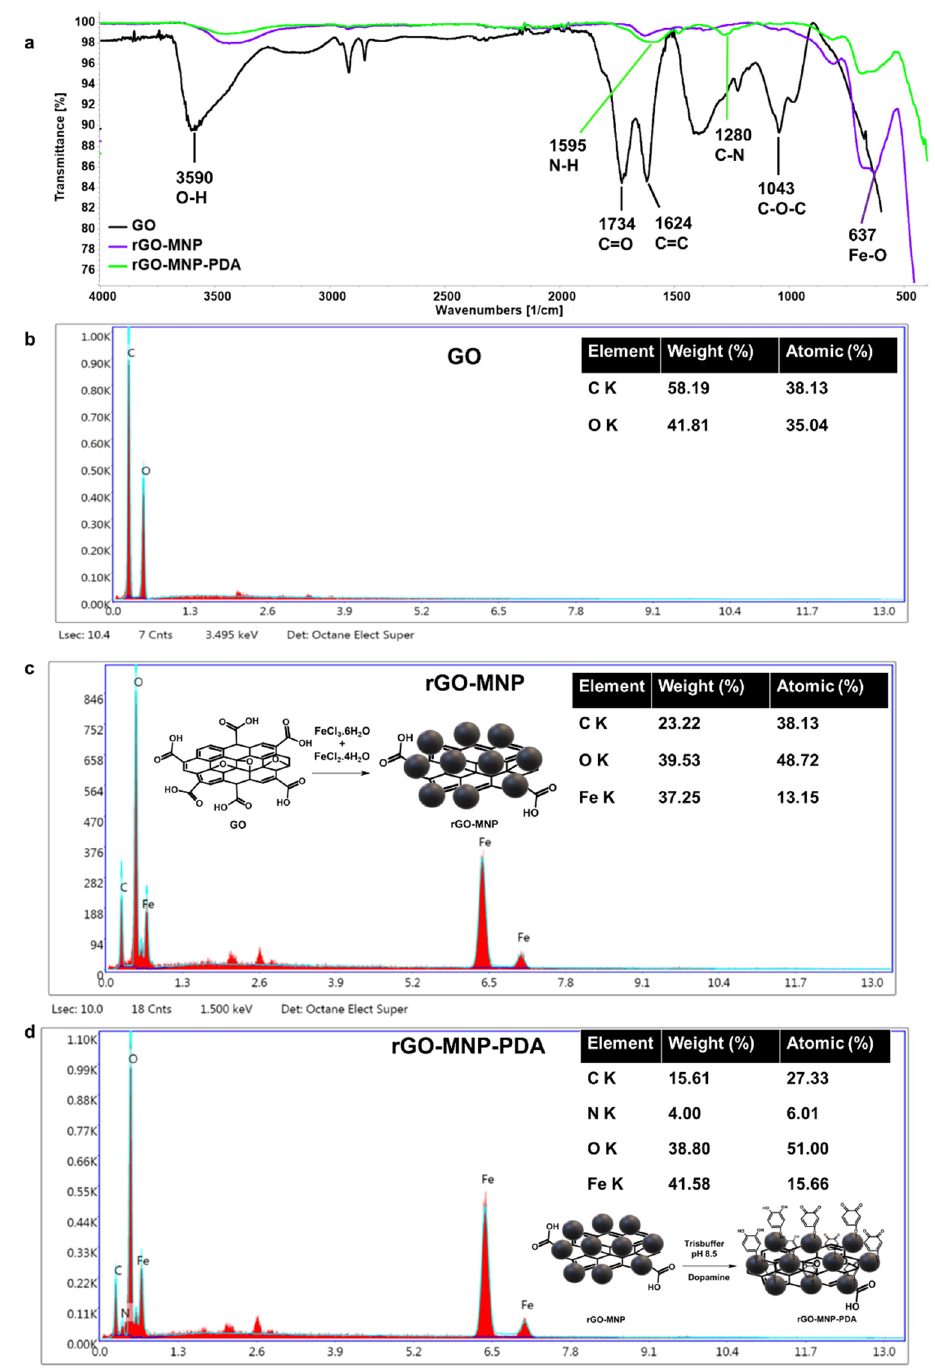
Figure 1. ( a ) FTIR spectrum of GO, rGO-MNP, rGO-MNP-PDA, ( b ) EDS spectrum of GO, ( c ) EDS spectrum of rGO-MNP, and ( d ) EDS spectrum of rGO-MNP-PDA. SEM images were taken to examine how to change the surface morphology of rGO- MNP-PDA nanocomposite after each modification step. A SEM image of non-modified GO nanosheets is shown in Figure 2a. MNPs tend to aggregate due to their hydrophobic nature. Aggregated MNPs were observed on the GO nanosheets (Figure 2b) after the mod- ification of GO with MNP. The surface of the rGO-MNP nanocomposite appeared to be- come smoother after coating with PDA (Figure 2c).